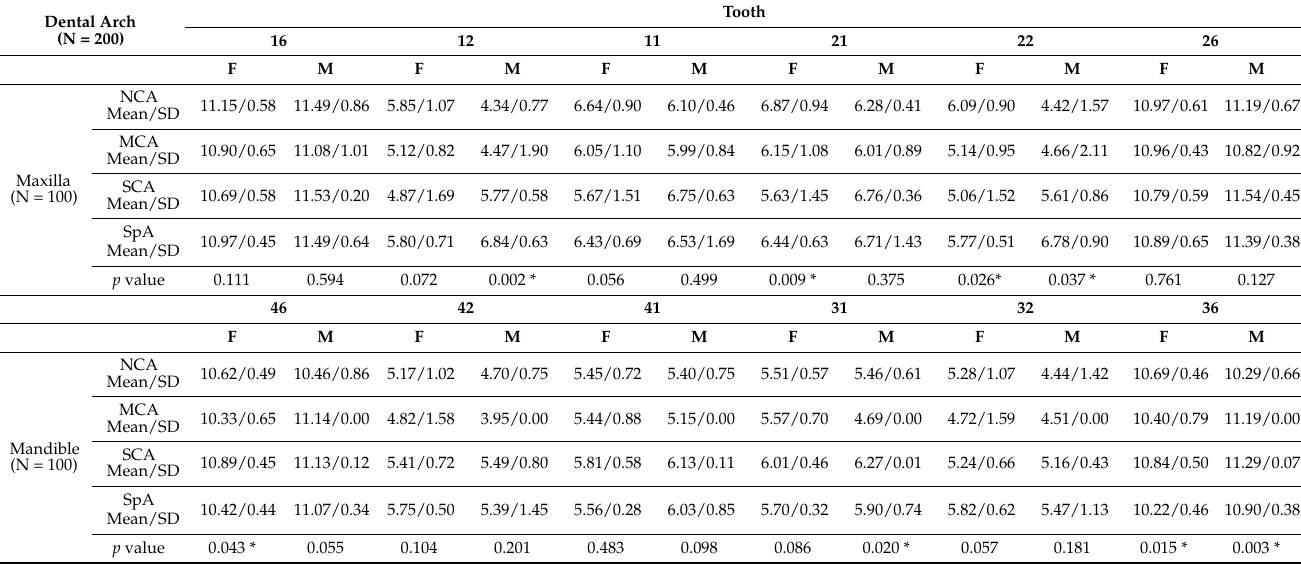
Table 7. Bucco-lingual dimensions (mm) of permanent incisors and first permanent molars for female and male patients in the four groups (statistical significance according to ANOVA analysis).